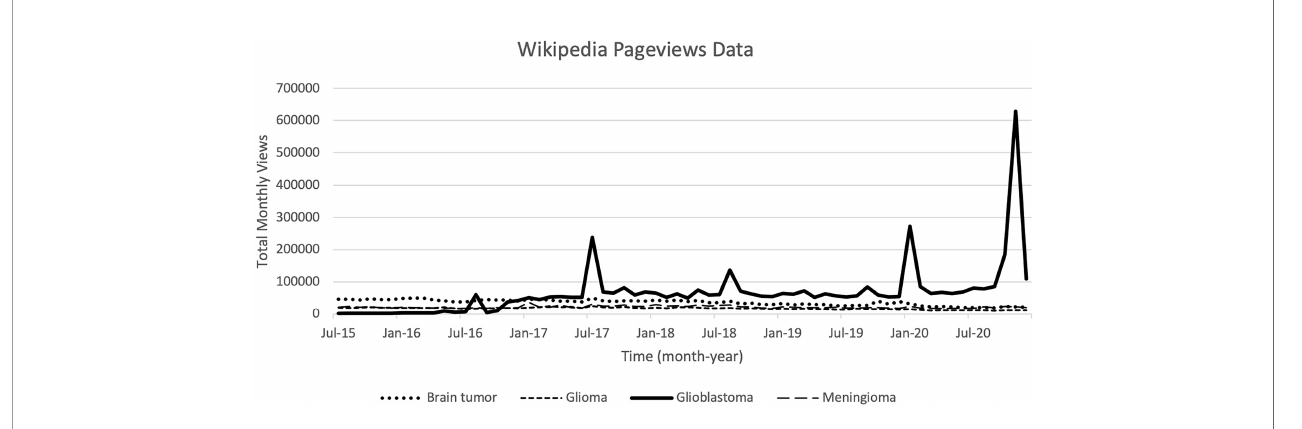
FIGURE 2 | Trends of Wikipedia Pageviews for selected search term keywords plotted against time since July